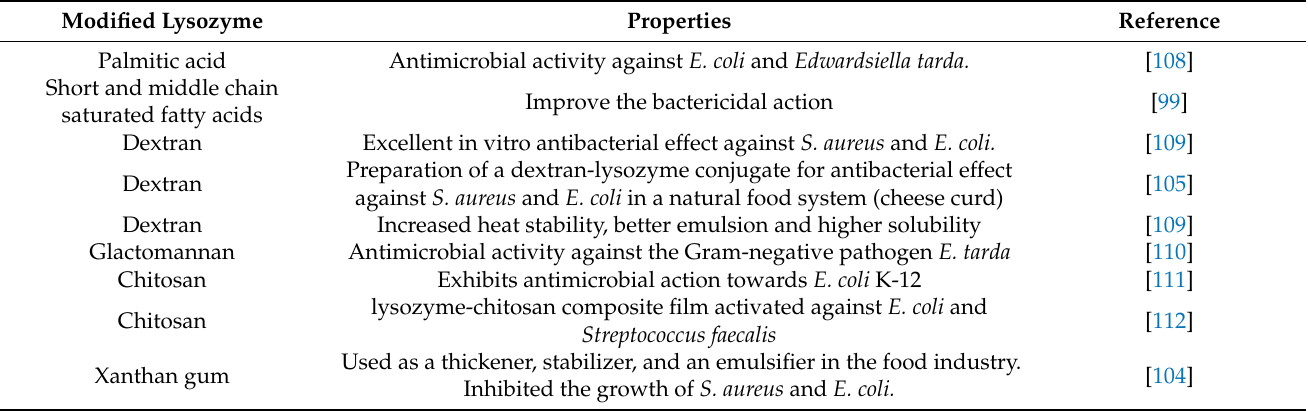
Table 3. Modified Lysozymes with their